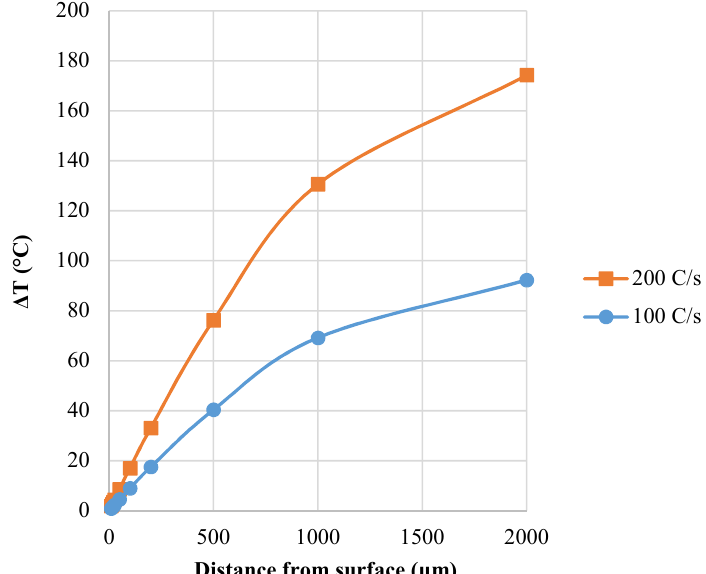
Figure 11. Estimated radial temperature gradients in 4-mm diameter SLM IN718 dilatometer samples for two heating rate. Surface temperature is 1000 °C.